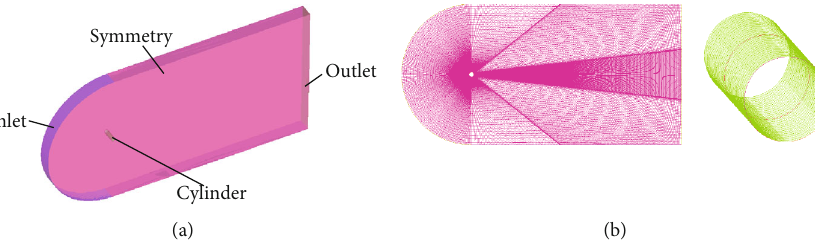
Figure 11: Mesh generation of a cylinder: (a) calculated three-dimensional domain and (b) mesh.